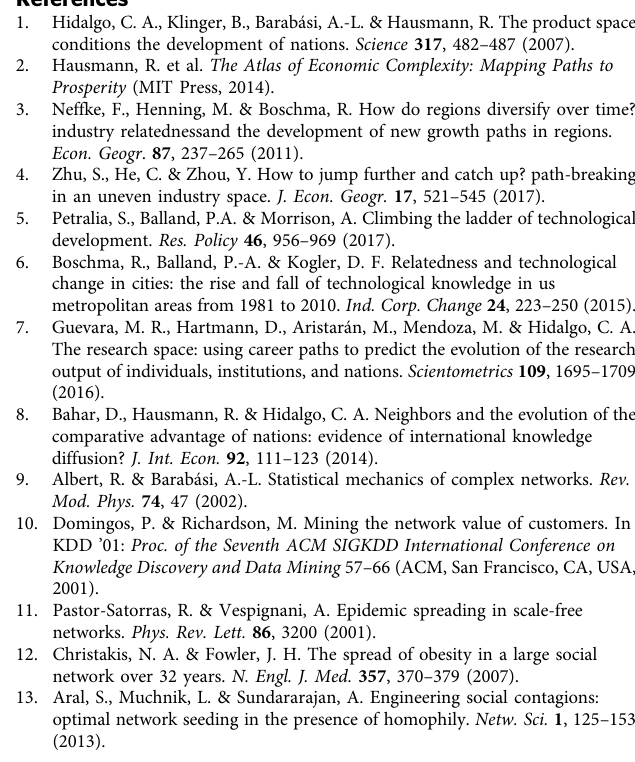
Fig. 3 The dynamics of economic and research diversi fi cation. a Boxplot showing the average connectivity of newly developed products in the product space as a function of the diversi fi cation level of the countries entering that product. The red line shows the fi t for the empirical values (the results of the statistical test for the signi fi cance is shown at the top) and the purple line shows the optimal mix of greedy and majority strategies obtained via numerical simulations. The black line shows the null model baseline which uses the random strategy. b Boxplot showing the average connectivity of newly developed research areas in the research space as a function of the diversi fi cation level of the countries entering that area. The red line shows the fi t for the empirical values (the results of the statistical test for the signi fi cance is shown at the top), and the purple line shows the optimal mix of greedy and majority strategies obtained via numerical simulations. The black line shows the null model baseline which uses the random strategy. There is a bin missing in b (at diversi fi cation = 0.6) because there were no events with that value on the observation period. In both a and b boxplots show the interquartile range inside the box, and have whiskers that extend to the top 95% and bottom 5% of the